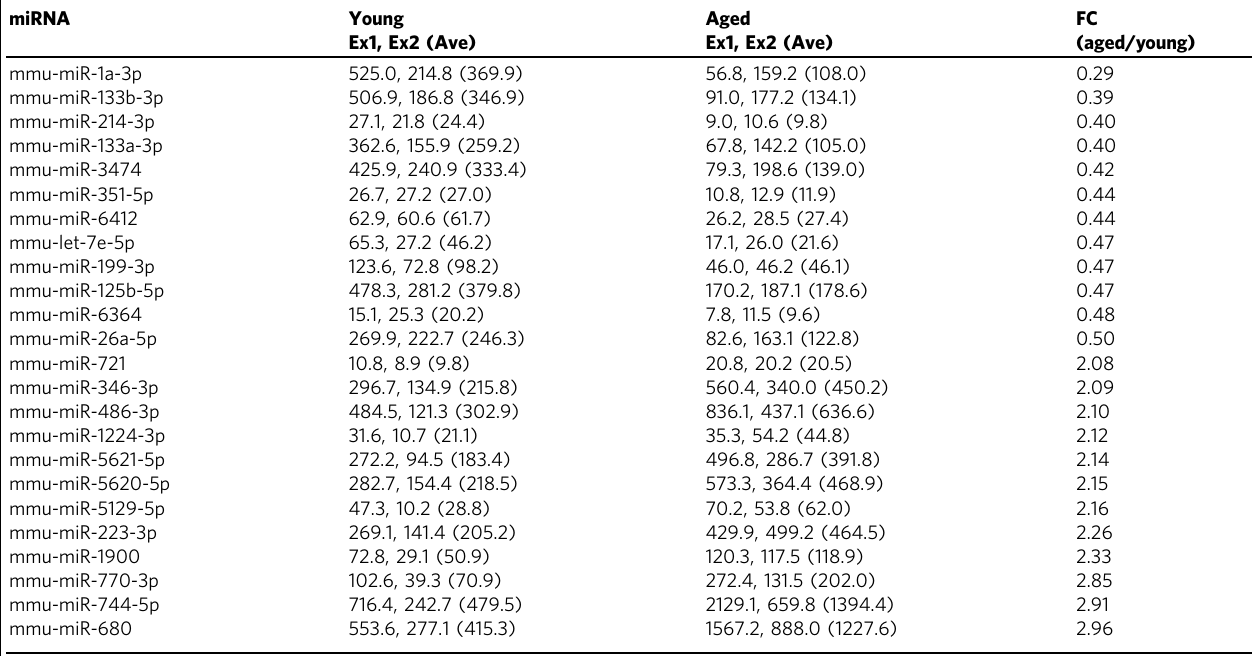
Signal intensities obtained from duplicated microarray analyses (experiments 1 and 2: Ex1, Ex2) and averages in parentheses (Ave) are indicated. Fold changes (FC) in the averaged level of cf-miRNAs between aged and young mouse blood are calculated. The top 12 cf-miRNAs from the lowest FC and highest FC are indicated.